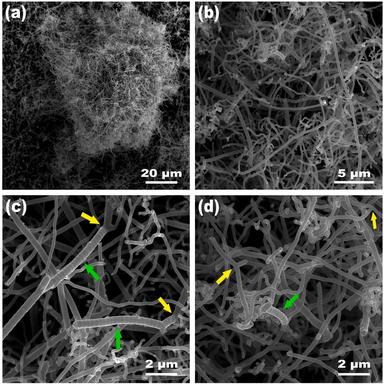
SEM images of NP-CNTSs with 60 to 300 nm diameters. (a) Low magnification images displaying the entangled carbon nanotubes. (b–d) High magnification images showing different carbon nanotubes. The thin carbon nanotubes are entangled into knots. Carbon nanotubes with large diameters exhibited junctions. Green arrows indicate carbon nanotubes with a coil morphology. Carbon nanotube junctions are indicated with yellow arrows. (For interpretation of the references to color in this figure legend, the reader is re